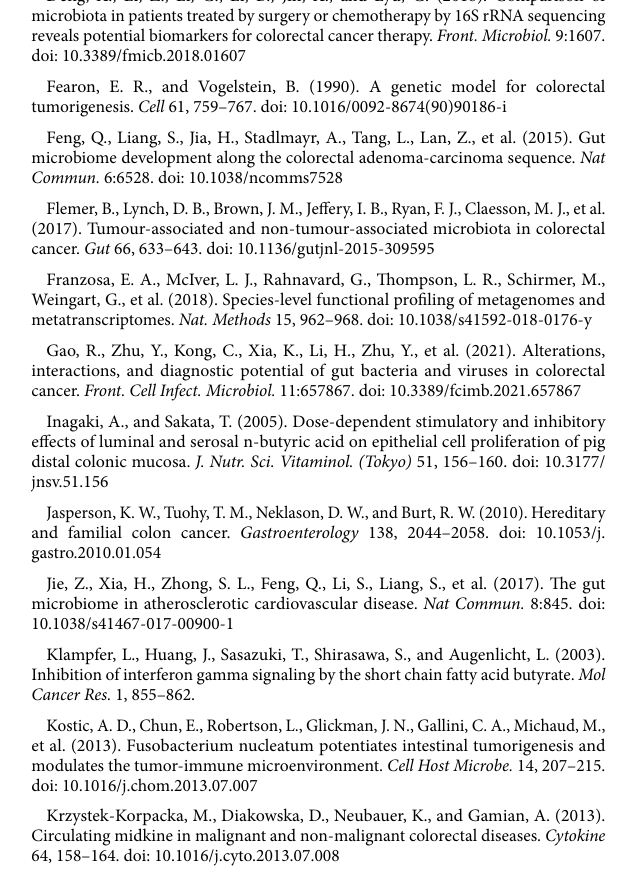
SUPPLEMENTARY FIGURE S1 The flow chart of this study. SUPPLEMENTARY FIGURE S2 Boxplots of α -diversity in six metagenomic sequencing datasets. (A) Shannon index of α -diversity; (B) Simpson index; All boxplots represent the 25th–75th percentile of the distribution; the median is shown in a thick line at the middle of the box. Green, HC samples; Pink, CA patients; Blue, CRC patients; ***: p < 0.001, **: p < 0.01, *: p < 0.05, ns: p > 0.05. SUPPLEMENTARY FIGURE S3 PCoA of samples based on Bray–Curtis distance in six metagenomic sequencing datasets. p -values of β -diversity based on Bray–Curtis distance were calculated with PERMANOVA. SUPPLEMENTARY FIGURE S4 Dispersion of samples based on Bray–Curtis distance in six metagenomic sequencing datasets. (A) FengQ cohort. (B) ThomasAM_2018a cohort. (C) ThomasAM_2018b cohort. (D) VogtmannE cohort. (E) ZellerG cohort. (F) YuJ cohort. SUPPLEMENTARY FIGURE S5 Genera that abundance were significantly altered with disease progressed. (A) ZellerG cohort. (B) ThomasAM_2018a cohort. SUPPLEMENTARY FIGURE S6 The performances of signature-HC and signature-CA compared to other publications. (A) The average AUC of signature-HC resulting from study- to-study transfer validation and the AUC values of the published models in six metagenomic datasets. (B,C) The boxplots of AUC values for study- to-study transfer validation of signature-HC (signature-CA) and RF models proposed by Thomas et al. All boxplots represent the 25th–75th percentile of the distribution; the median is shown in a thick line at the middle of the